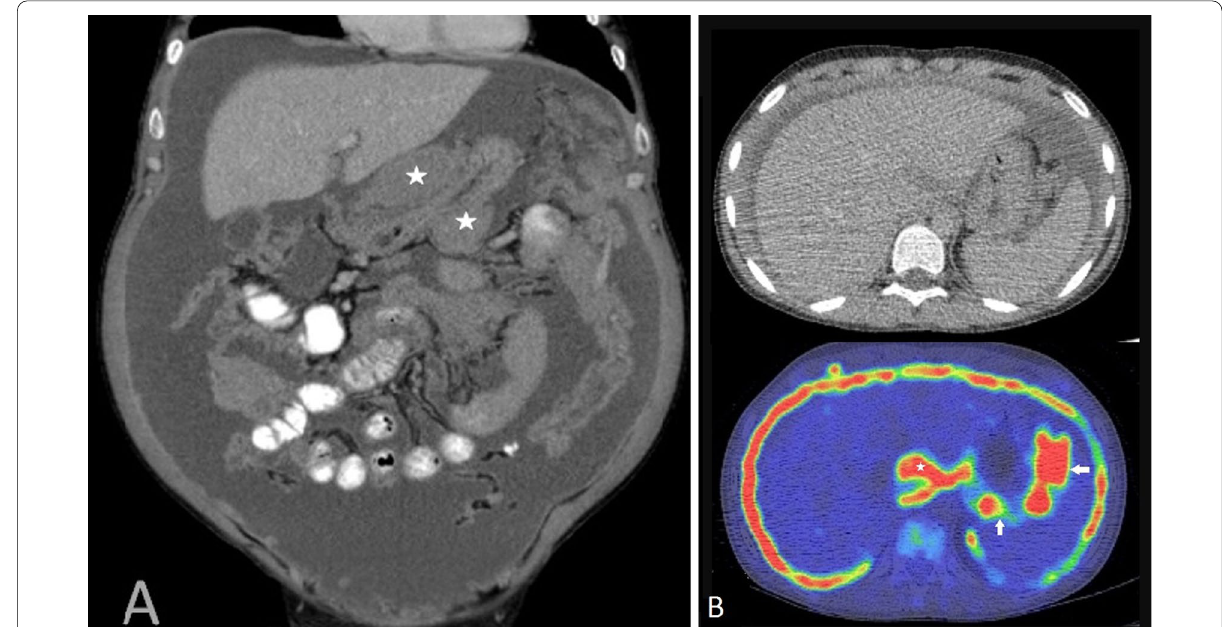
Fig. 13 a , b Images of two patients with epithelioid malignant peritoneal mesothelioma showing disease in the epigastric region. a Coronal CT with extensive peri-gastric disease (*) seen as soft tissue masses around the stomach. Also note the tethered mesentery. b Axial PET-CT images showing FDG-avid disease in the lesser omentum, lesser sac, porta (*) and peri-gastric region